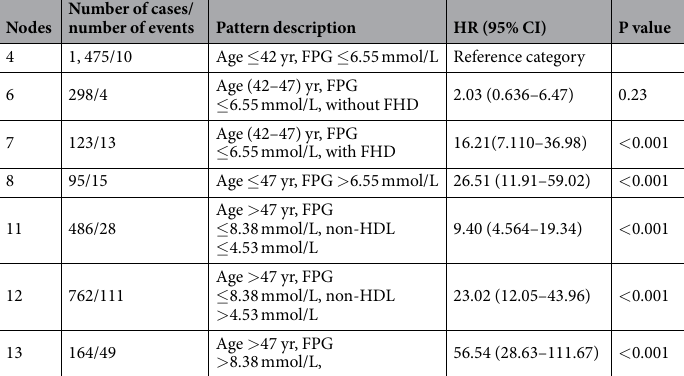
Table 4. Cox analyses of patterns identified using survival tree in the female population, Tehran Lipid and Glucose Study (1999–2012). Nodes : Terminal nodes number of survival tree for women; CI: Confidence intervals; FPG: Fasting plasma glucose ; FHD : Family history of diabetes; HR : Hazard ratio.